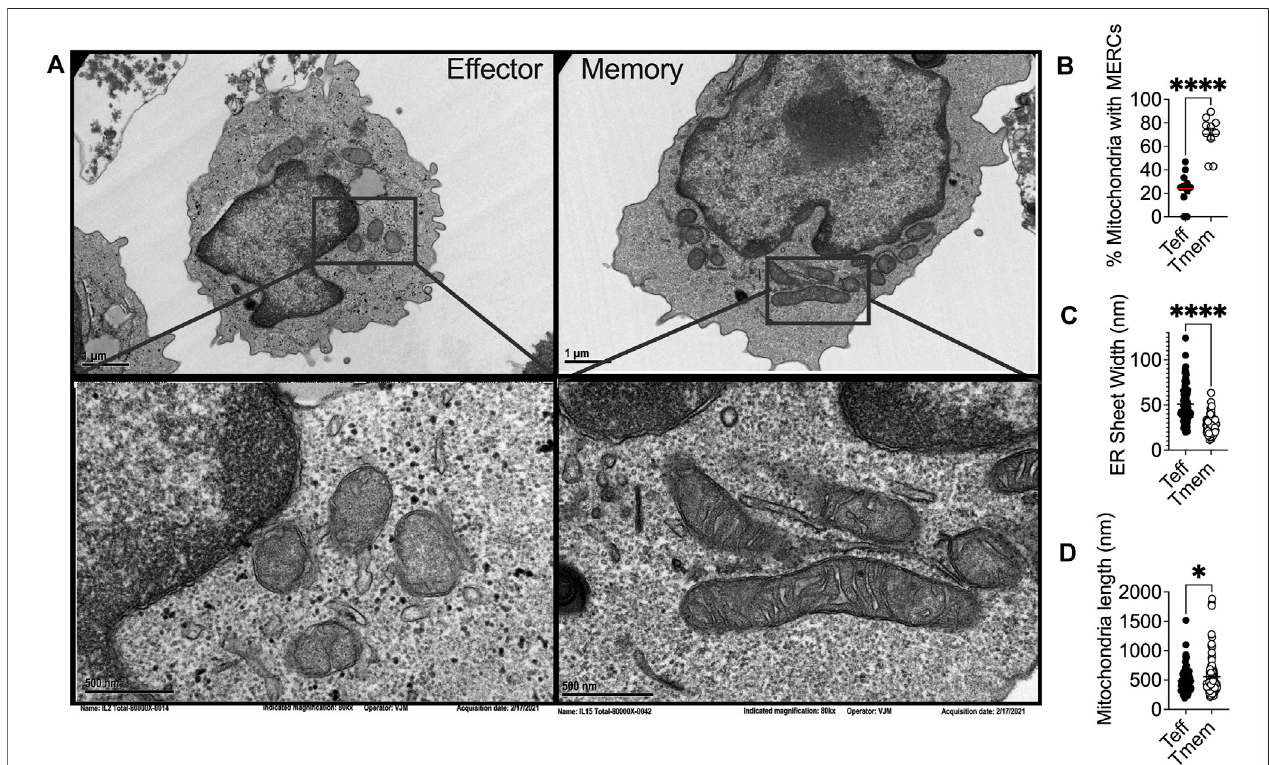
FIGURE 1 | (A) Representative transmission electron microscopy of IL2 and IL15-derived effector and memory-like T cells, respectively, illustrating differential ER and mitochondrial biology in T cell subsets in alignment with previous reports that elucidated the phenomenon. Ex vivo expanded OT-1 T cells activated and expanded for3 days withOVApeptidewereconditionedforfourmoredays inIL2(200U)orIL15(50 ng/ml)and (B) percentage ofmitochondriapossessingMERCs (C) ERluminal width and (D) mitochondrial length were quanti fi ed.